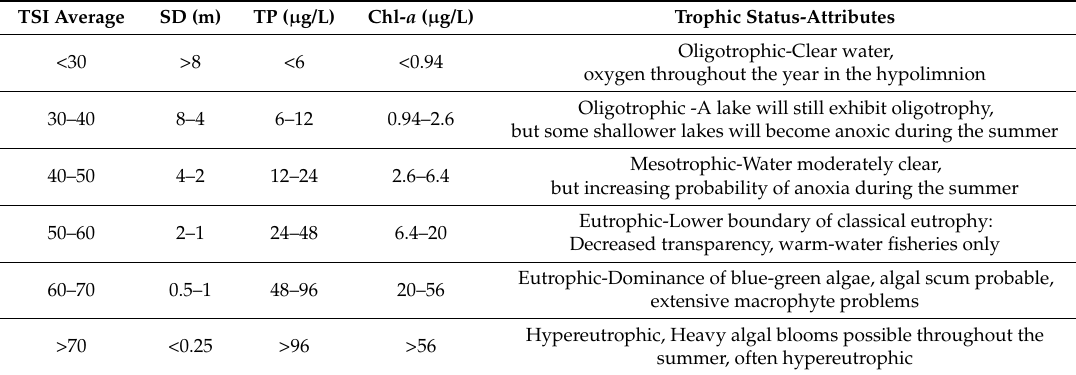
Table 1. Proposed lake water quality classification system by United States EPA (Environmental Protection Agency)